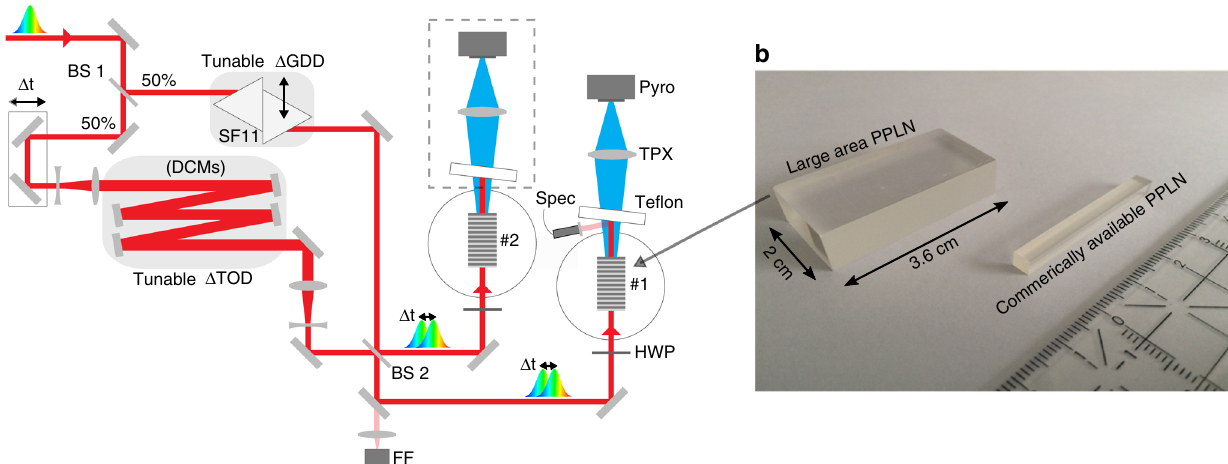
Fig. 2 Narrowband THz setup. a The driver laser output is split into two identical copies, whose GDD and TOD are independently tuned using a variable amount of high-dispersive SF11 glass (adding GDD), and a set of dispersion compensating mirrors (DCM), each adding a discrete amount of TOD. The recombined pulses generate narrowband THz pulses in large-aperture cryogenically cooled magnesium-doped PPLN crystals, shown in the photograph ( b ). To characterise the THz pulses, a pyroelectric detector is used either directly (pulse energy) or as the detector in a longitudinal interferometer (frequency). BS: beam splitter; FF: far fi eld camera; HWP: half-wave plate